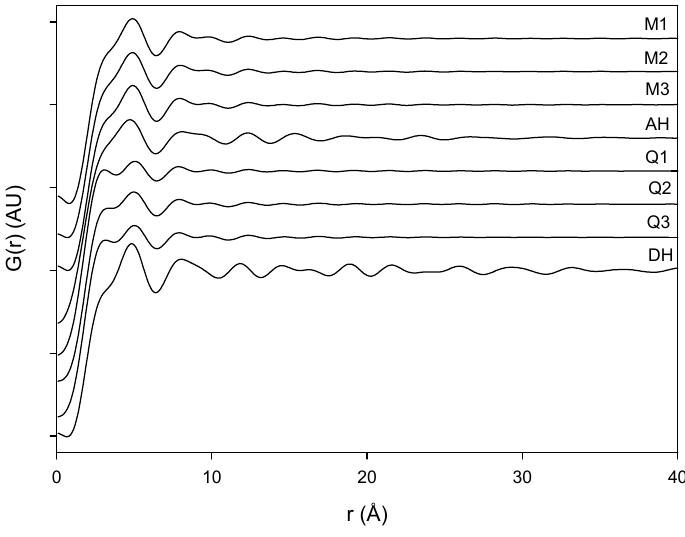
Figure 6. PDF pattern of the milled samples (M1, M2 and M3), quench cooled samples (Q1, Q2 and Q3), crystalline anhydrate (AH) and crystalline dihydrate (DH).